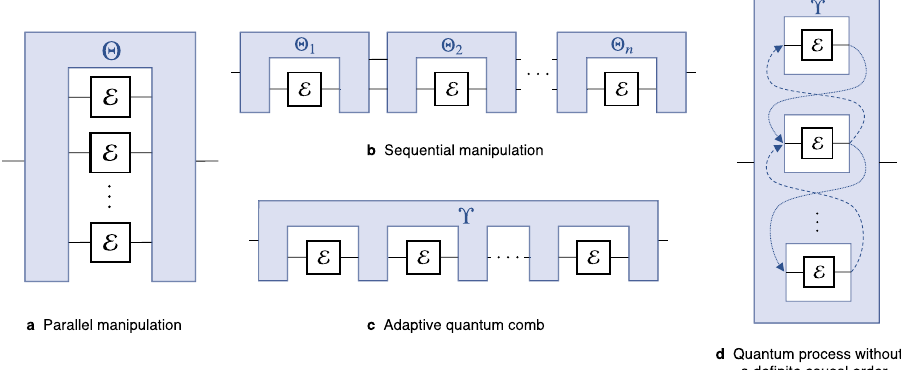
Fig. 2 The different ways to manipulate many copies of a quantum channel with free transformations. For quantum states, having access to multiple copies of a state ρ is equivalent to acting on the tensor product ρ ⊗ n . A naive way to employ n copies of a given channel is to consider them in parallel as E (cid:4) n ( a ). However, a more general way to manipulate n copies of a channel is to employ a sequential (iterative) protocol ( b ), which can be understood as the channel E being fed into a sequence of n free superchannels one after another, allowing one to use the output of the previous channel uses to improve the transformation. Indeed, such protocols are known to provide advantages over parallel ones in some settings 23,76 – 79 , and this approach is commonly employed to transform channels in the setting of various resource theories such as quantum communication 17,80 – 82 , entanglement 83,84 , or magic 48 . However, even this does not represent the most general way to manipulate multiple channels within the setting of the given resource theory. When the causal order of the channels is fi xed, any n -channel transformation scheme by means of a quantum circuit can be expressed as a so-called quantum comb 2 ( c ). Even more complex manipulation strategies are possible if one does not assume a de fi nite causal order between the channel transformations, that is, when one is not able to say in what order the channels will be used throughout the protocol ( d ). Such an approach allows one to treat the transformation trajectories themselves as quantum objects, leading to concepts such as superpositions of different causal orders 12,13 which can indeed provide advantages over standard, causally ordered transformation methods 12,79,85 . These transformations are dubbed quantum processes, and we will use them to characterise the most general physically realisable manipulation protocols involving multiple quantum